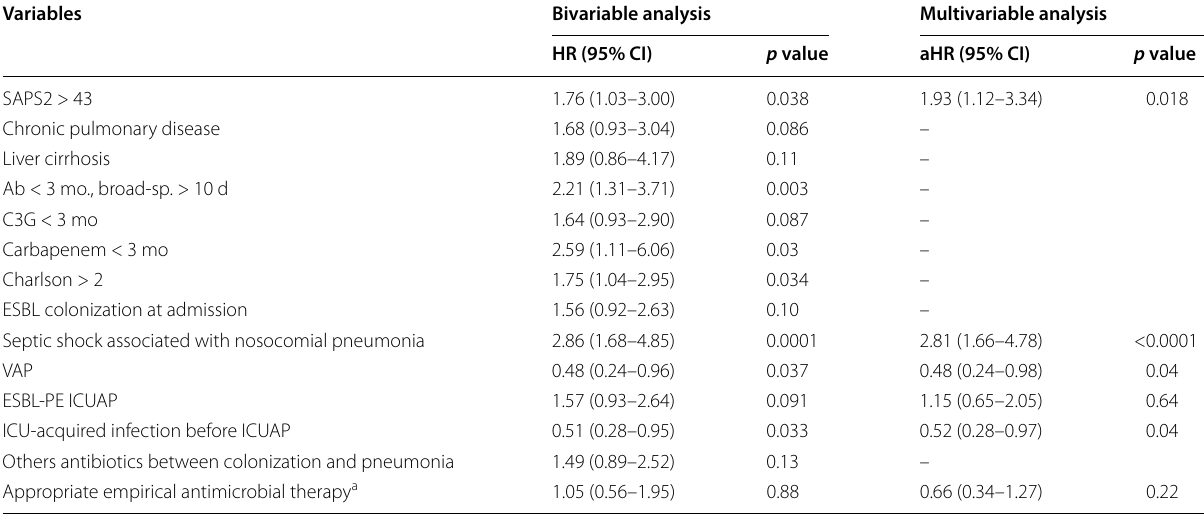
Ab antibiotic, broad-sp. broad-spectrum, 3GC third-generation cephalosporin; iBL beta-lactamase inhibitor, mo month, VAP ventilator-associated pneumonia, ICUAP ICU-acquired pneumonia, <3 mo within 3 months before ICU admission, HR (95% CI) hazard ratio interquartile range